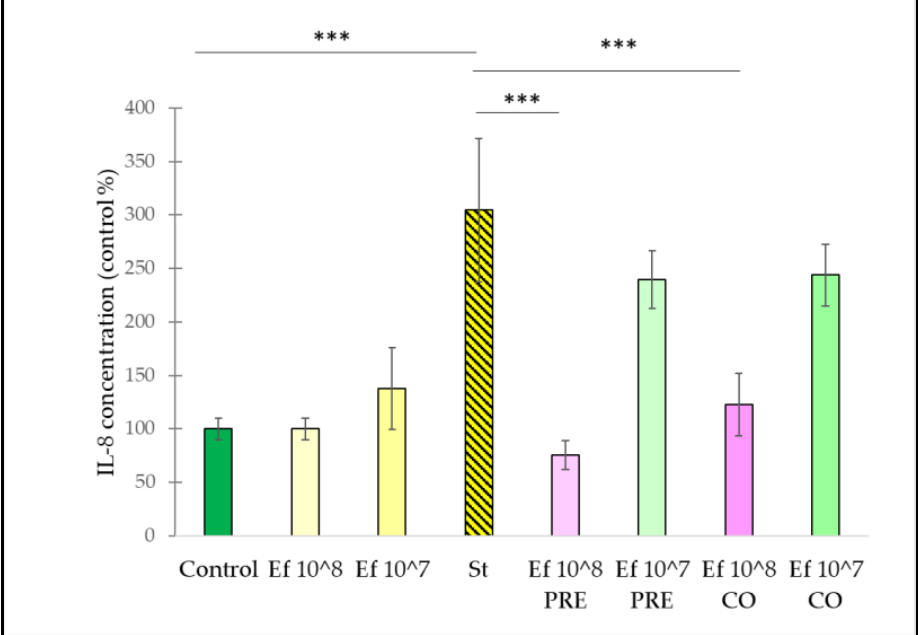
Figure 7. Induction of IL-8 secretion of IPEC-J2 cells after stimulation with S. Typhimurium and E. faecium . E. faecium was added 1 h before (pre-treatment) or at the same time (co-treatment) of the